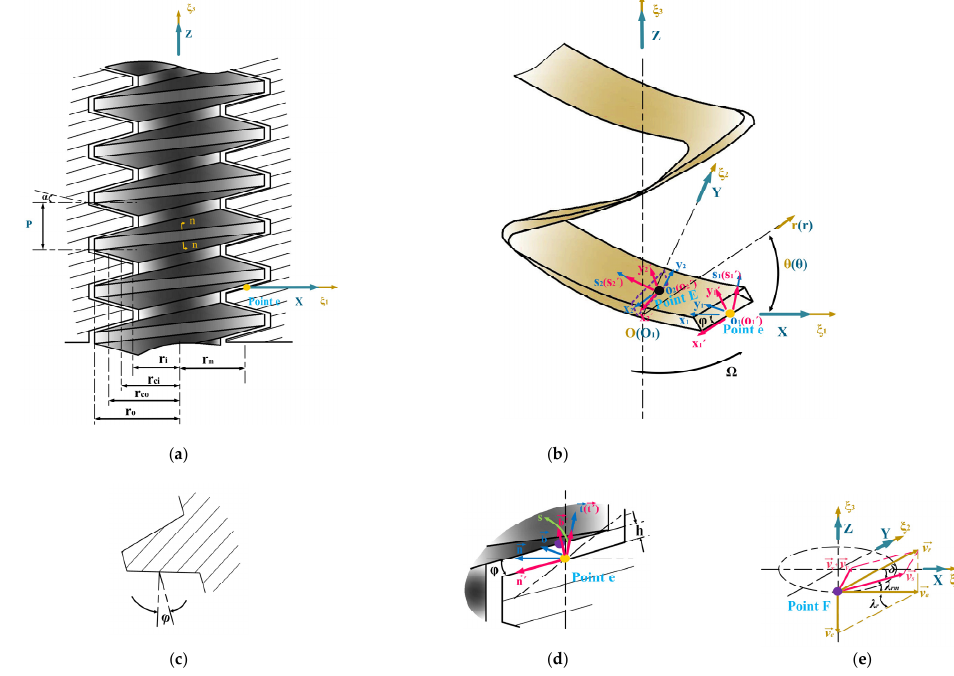
Figure 1. Modeling diagram based on the helical coordinate system. ( a ) Schematic diagram; ( b ) modeling of fluid domain; ( c ) “ n - n ” of the screw; ( d ) initial section; ( e ) velocity relations. As shown in Figure 1b,d, a helical coordinate system “ sxy ”, composed of the s -axis and a follow-up coordinate system “ oxy ”, was constructed on the upper helicoid of the nut [19,20]. The s -axis gone from point e along the pitch diameter helix of the helicoid, and “ oxy ” changed along the s -axis (tangent vector t ) to adapt to the normal and binor- mal vectors ( n and b ) of the Frenet frame of pitch diameter helix.